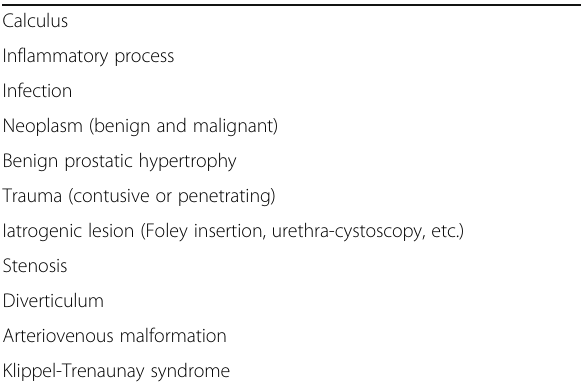
Table 1 Causes of uretrorragia